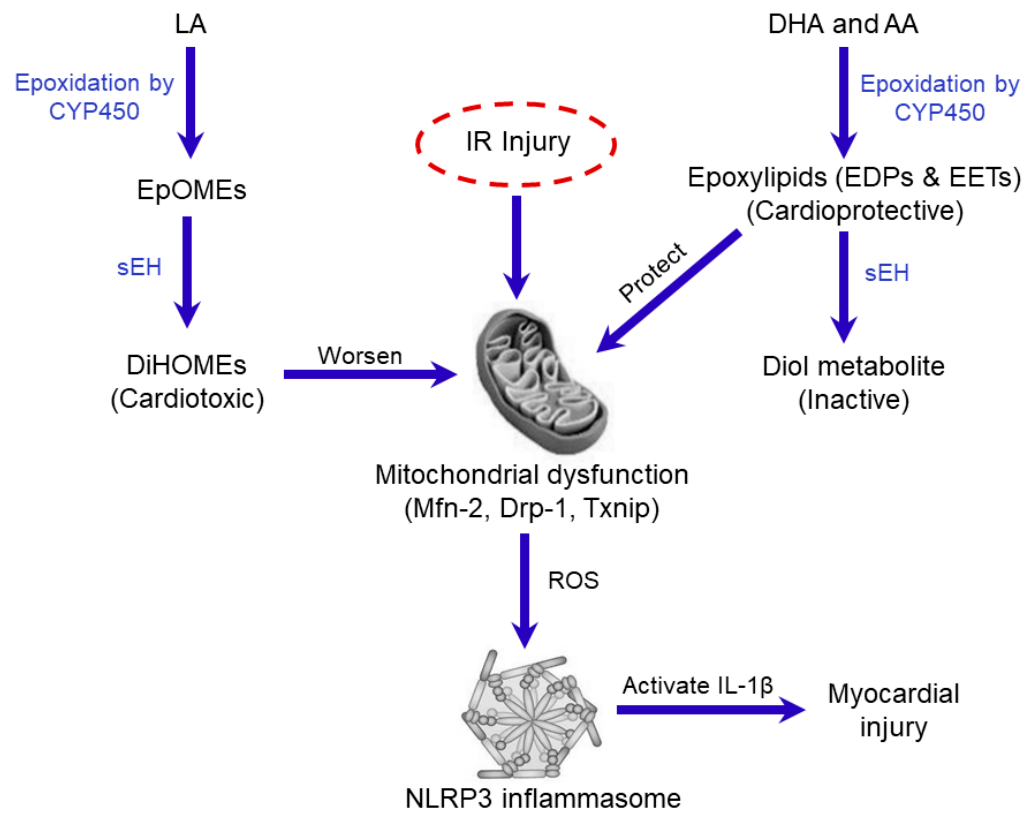
Figure 7. Schematic showing the potential roles of sEH in IR injury. Cellular injury in response to IR insult is associated with the release of polyunsaturated fatty acids (PUFAs) from the cell membrane which can be metabolized via epoxidation by cytochrome P450 (CYP450) isoenzymes to linoleic acid (LA) metabolites epoxyoctadecenoic acids (EpOMEs), which are further metabolized by sEH to dihydroxyoctadecenoic acid (DiHOMEs) with cardiotoxic effects targeting mitochondria resulting in injury. In contrast, sEH rapidly degrades the cardioprotective epoxylipids, epoxydocosapentaenoic acids (EDPs) and epoxyeicosatrienoic acids (EETs), generated from the CYP-mediated metabolism of the n-3 docosahexaenoic acid (DHA) and n-6 arachidonic acid (AA), respectively. These biologically active epoxy metabolites mediate many of the beneficial cardiovascular effects of the parent PUFAs by maintaining mitochondrial quality and reducing adverse inflammatory reactions. IR injury triggers the translocation of dynamin-related protein-1 (Drp-1) from the cytosol to the mitochondria initiating events that lead to the assembly and oligomerization of NLPR3 inflammasome. Active NLPR3 shuttles Txnip to the mitochondria aggravating mitochondrial damage as well the formation of the pro-inflammatory cytokine IL-1 β triggering cardiomyocyte cell death.